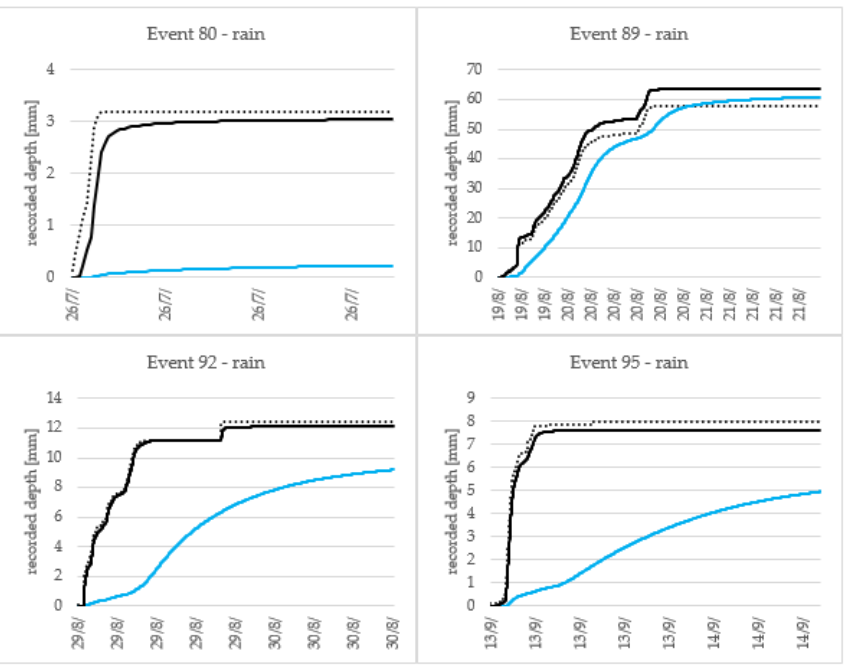
Figure 5. Cumulative runoff responses to the events with the highest peak 5-min intensity.